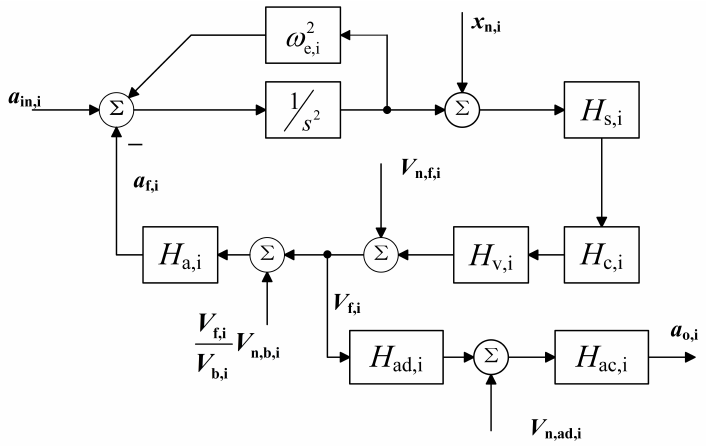
Figure 3. The noise model of the